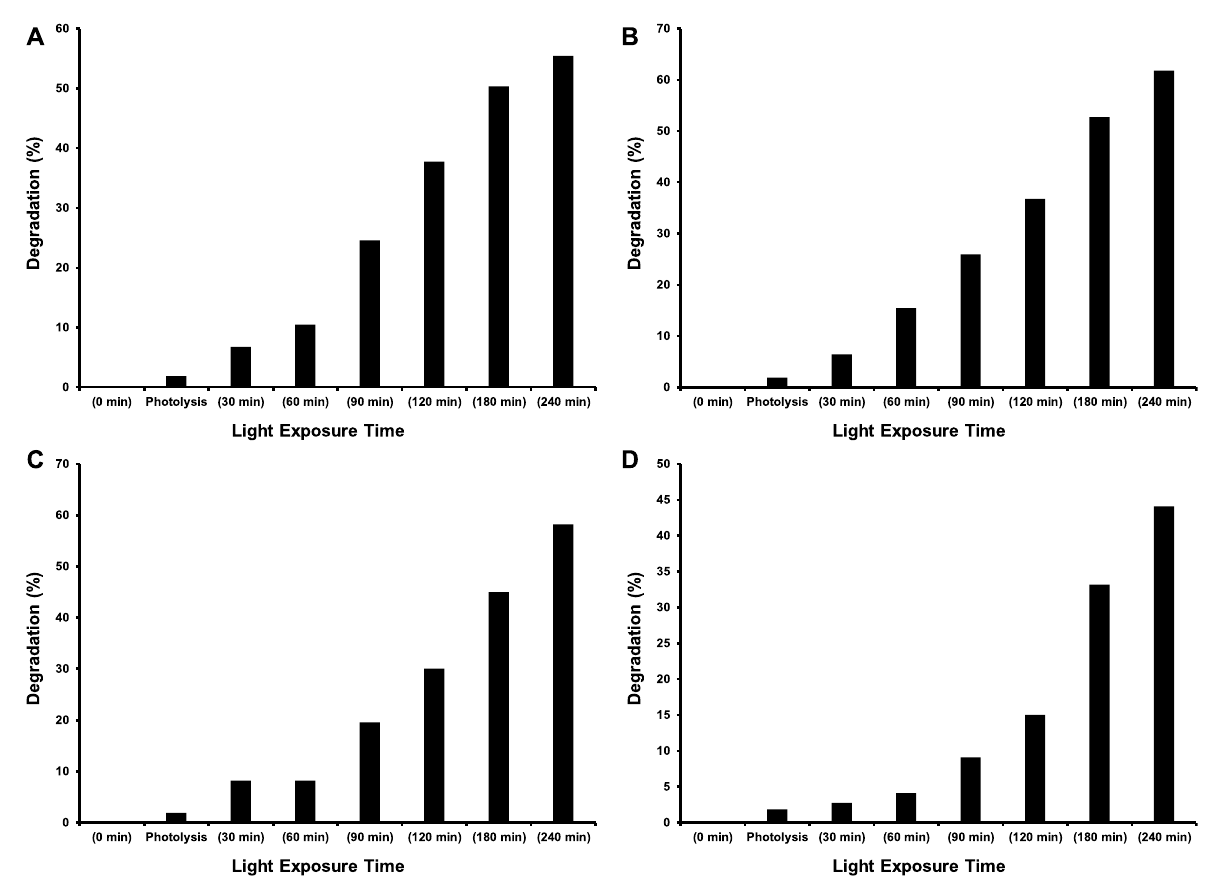
FIGURE 7 Thecomparisonof%degradationof15 ppm2-CPover (A) CeO 2 (B) FedopedCeO 2 (C) CudopedCeO 2 and (D) NidopedCeO 2 atdifferentintervals of time under the illumination of indoor white light (800 × 10 2